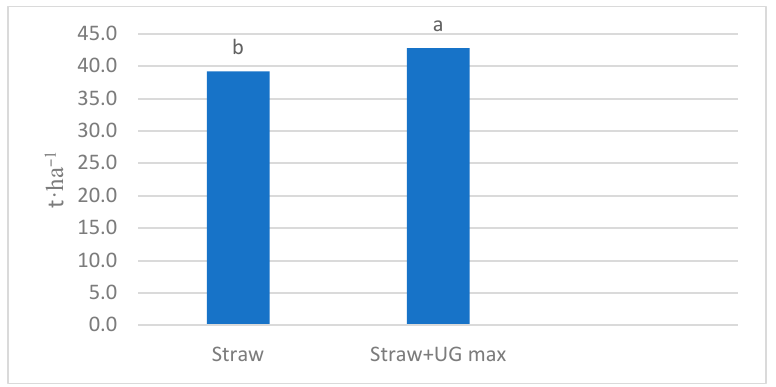
Figure 4. Effect of UG max Soil Fertilizer on potato tuber yield. a,b-mean values indicated by the same letters are not statistically significant at the 0.05 level by Tukey’s test.